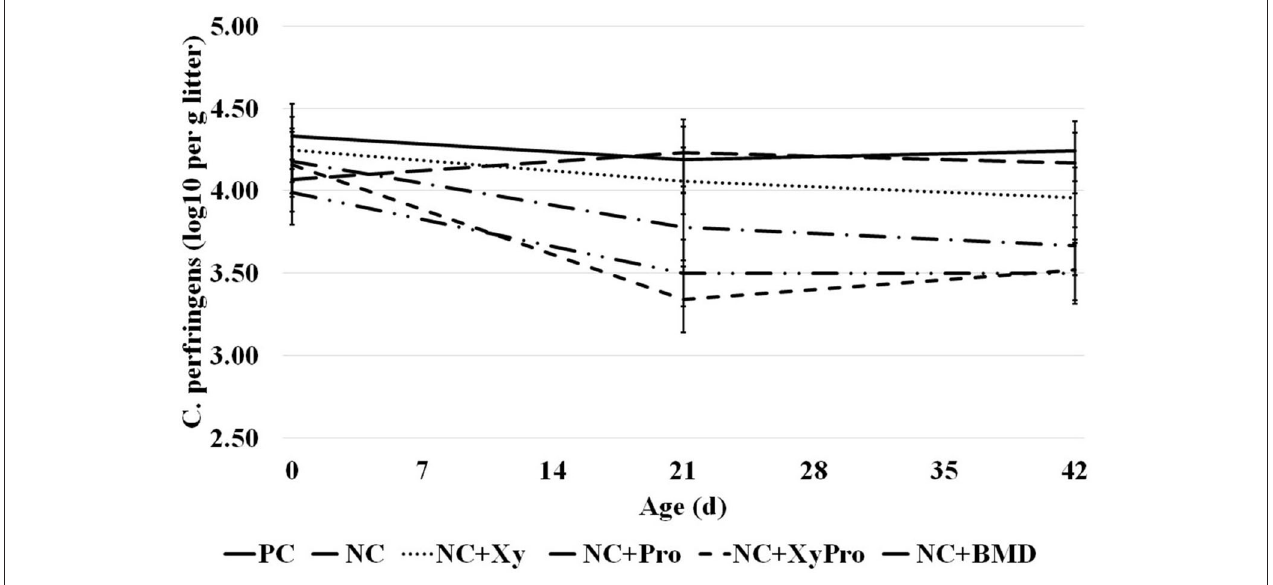
FIGURE 1 | Abundance of C. perfringens in litter samples collected from pens with birds raised to 42 days and consumed one of the experimental diets: PC, positive control; NC, negative control with ME 130 kcal/kg lower than PC; NC + Xy, NC with xylanase; NC + Pro, NC with probiotics mix; NC + XyPro, NC with xylanase and